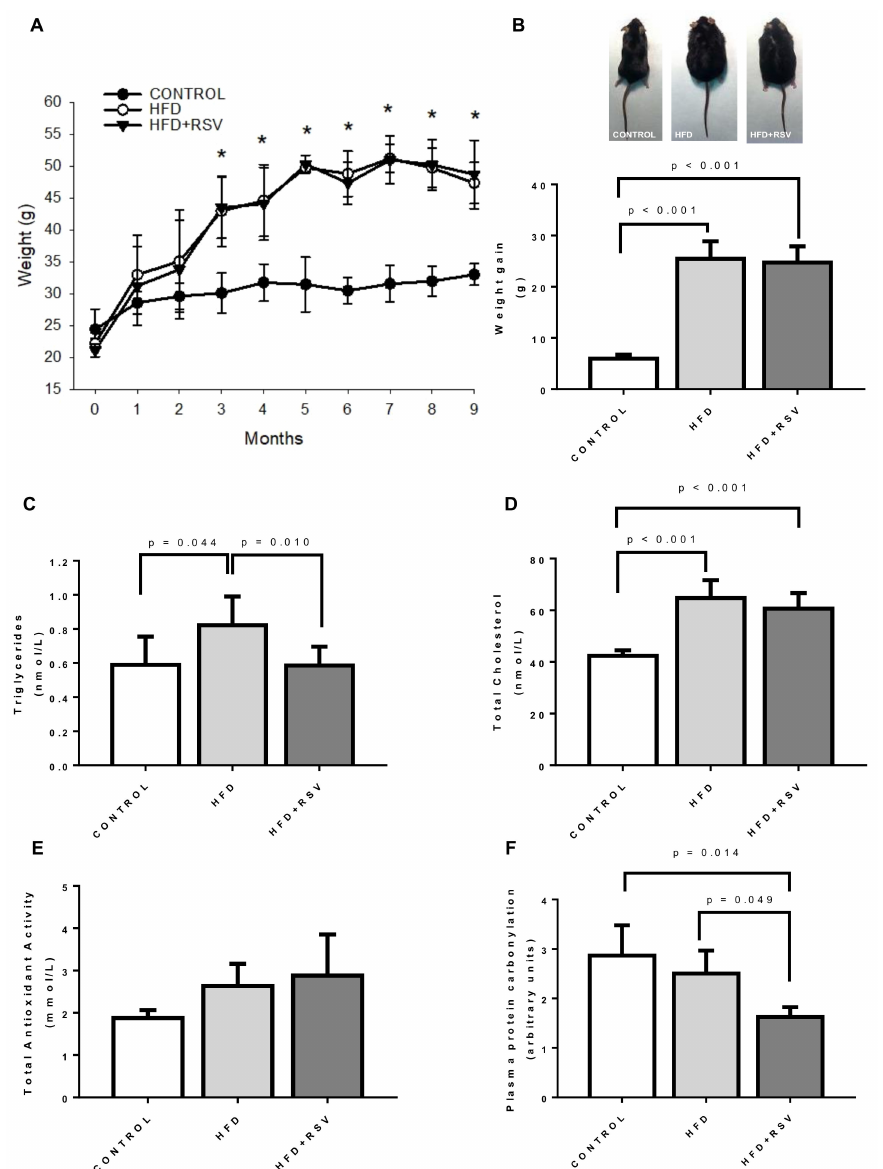
Figure 1. Markers of metabolic syndrome in mice. ( A ) Weight along experiment, * Statistical di ff erence vs. control group, p < 0.05. ( B ) Weight gain at the end of 9 months of experiment and representative picture of animals. ( C ) Triglycerides levels in plasma (nmol / L). ( D ) Total cholesterol levels in plasma (nmol / L). ( E ) Total antioxidant status (TAS) in plasma (mmol / L). ( F ) Plasma protein carbonylation levels in liver (arbitrary units). Statistical significance is indicated in each figure. HFD: high-fat diet; RSV: